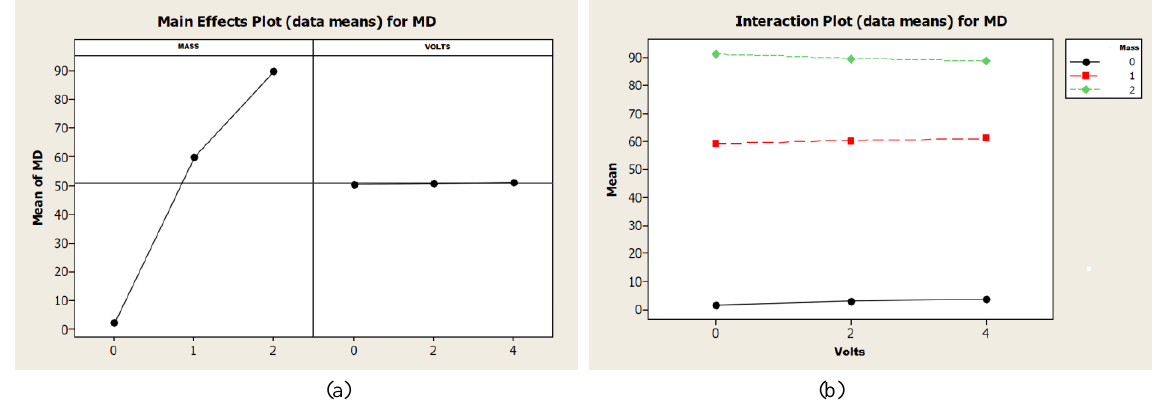
Fig. 7. Main effects of electromagnetic field: (a) Isolated effects; (b) Cross